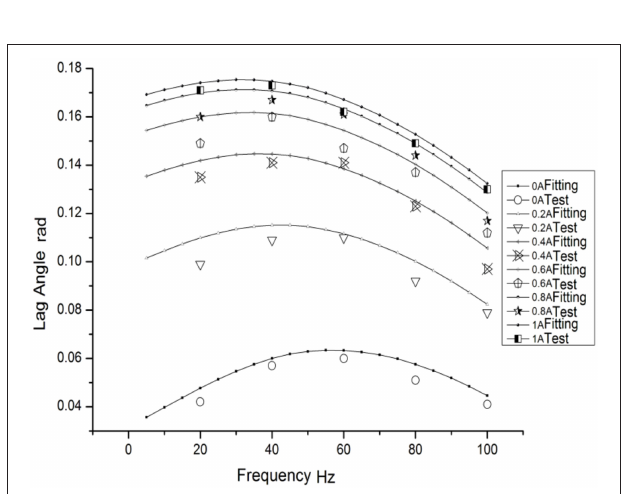
FIGURE 13 | Fitting experiment contrast figure of lagging angle of MR